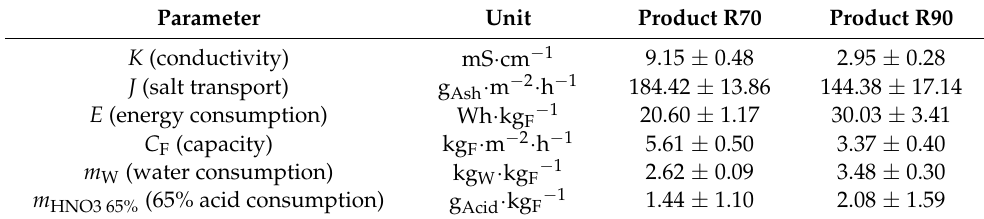
Table 2. Electrodialysis performance